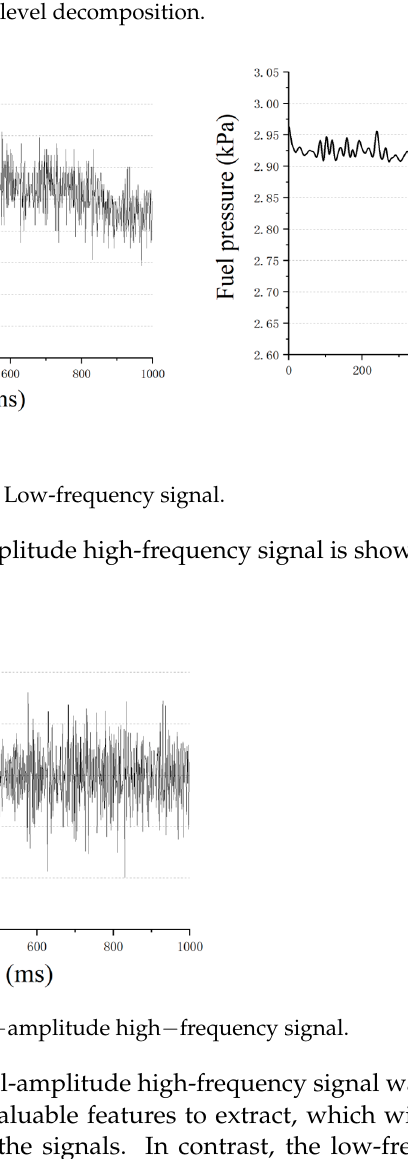
Figure 11. The filtered small − amplitude high − frequency signal.